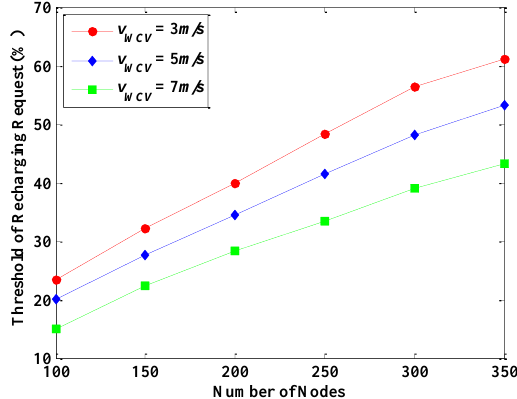
Figure 26. The average value of TRR under different number of nodes and different moving speeds.